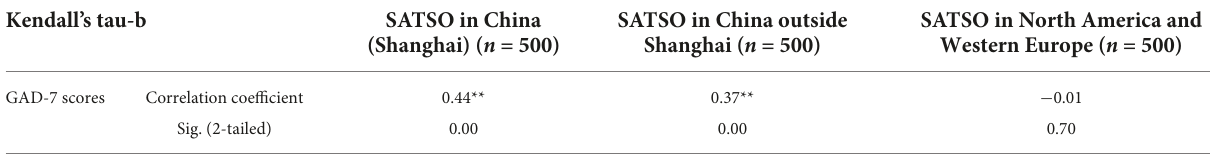
FIGURE1 Mean of GAD-7 scores by area.